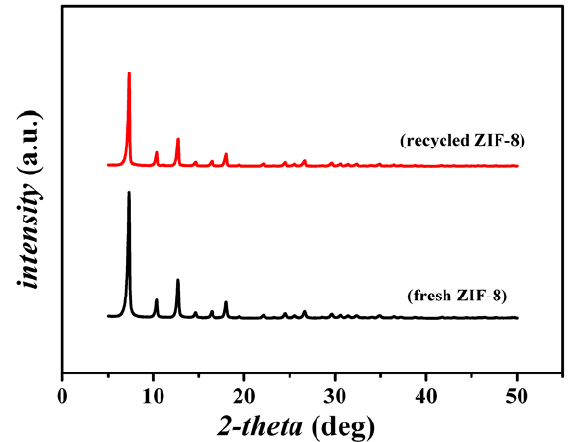
Figure 10. Comparison of the X ‐ ray diffraction patterns of fresh ZIF ‐ 8 and recycled ZIF ‐ 8 from a ZIF ‐ 8/water ‐ glycol slurry after the separation of C 3 H 6 /H 2 .